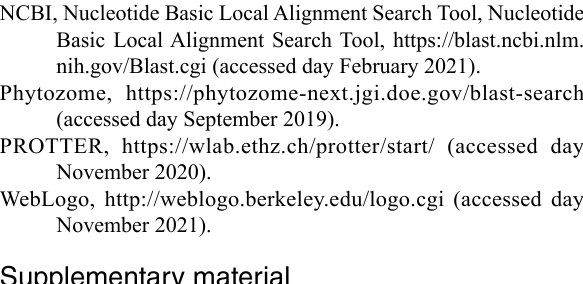
Figure S1 – Simplified species tree using the divergence time between pairs of representative organisms used from each major group. Figure S2 – Scheme of PSY gene duplications and losses. Figure S3 – Phylogenetic relationships among PSY genes belonging to subgroup E3 from Figure 1. Figure S4 – Phylogenetic relationships among PSY genes belonging to Subgroup E1 from Figure 1. Figure S5 – Phylogenetic relationships among PSY genes belonging to Subgroup E2 from Figure 1. Figure S6 – Phylogenetic relationships among PSY genes belonging to subgroup M1 from Figure 1. Figure S7 – Phylogenetic relationships among PSY genes belonging to Subgroup M2 from Figure 1. Figure S8 – Gene expression analysis across developmental stages of Arabidopsis thaliana performed using GENEVESTIGATOR database. Figure S9 – Gene expression analysis across anatomical parts of Arabidopsis thaliana performed using GENEVESTIGATOR. Figure S10 – Gene expression analysis across anatomical parts of Glycine max performed using GENEVESTIGATOR. Figure S11 – Gene expression analysis across developmental stages of Glycine max performed using GENEVESTIGATOR. Figure S12 – Gene expression analysis across developmental stages of Oryza sativa performed using GENEVESTIGATOR. Figure S13 – Gene expression analysis across anatomical parts of Oryza sativa performed using GENEVESTIGATOR. Figure S14 – Gene expression analysis across developmental Figure S15 – Gene expression analysis across anatomical